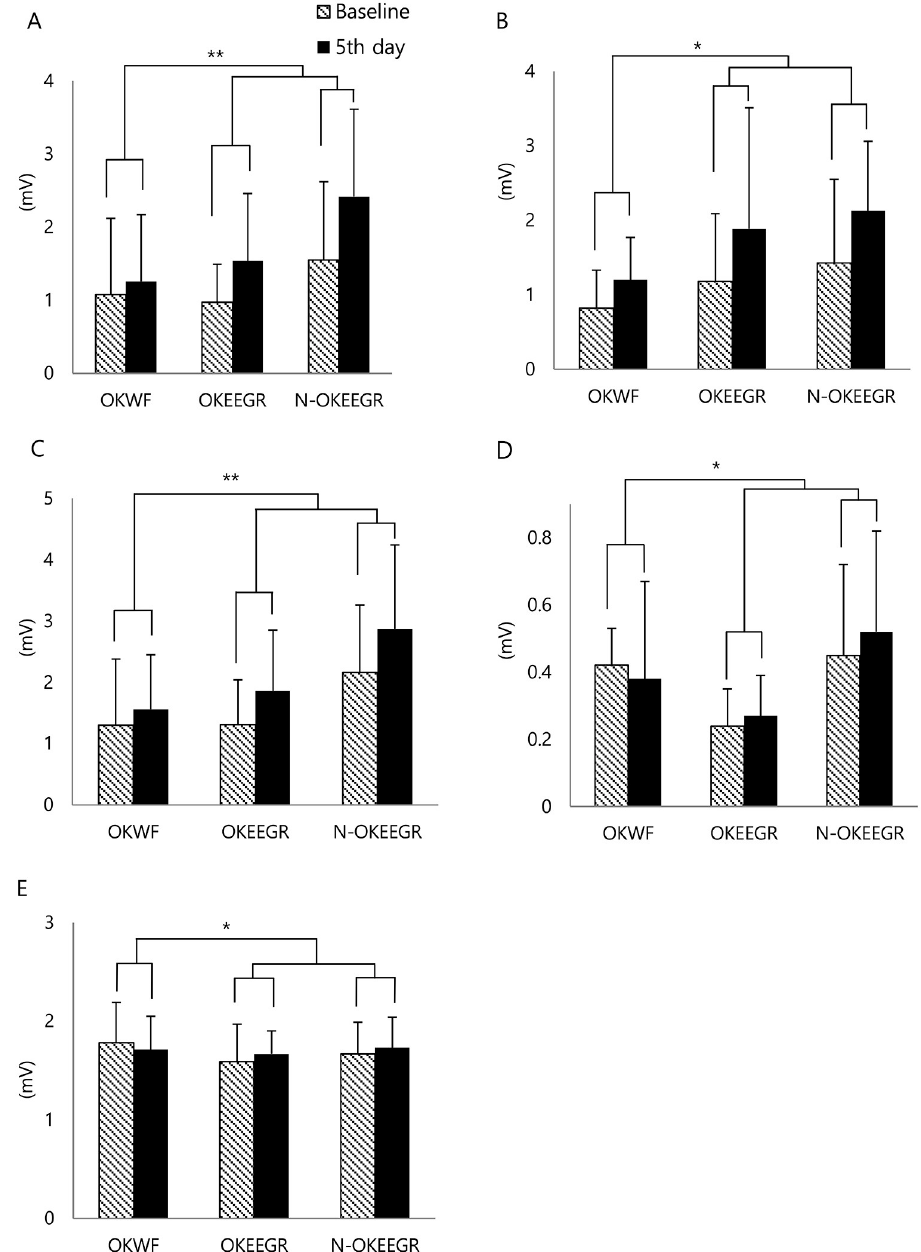
Fig 4. The cortical and spinal motor neuron excitability of the knee flexors and extensors. Compared with the operated knees in the WF group (OKWF), the operated knees in the EEGR group (OKEEGR) and the non-operated knees in the EEGR group (N-OKEEGR) showed more improvement in (A) the mean motor evoked potential amplitude of the vastus medialis, (B) the mean motor evoked potential amplitude of the biceps femoris long head, (C) the maximal motor evoked potential amplitude of the vastus medialis, (D) the maximal Hoffmann-reflex amplitude of the vastus medialis, and (E) the maximal Hoffmann-reflex amplitude of the biceps femoris long head. � p < 0.05, �� p < 0.01 by two-way repeated measures analysis of variance or paired